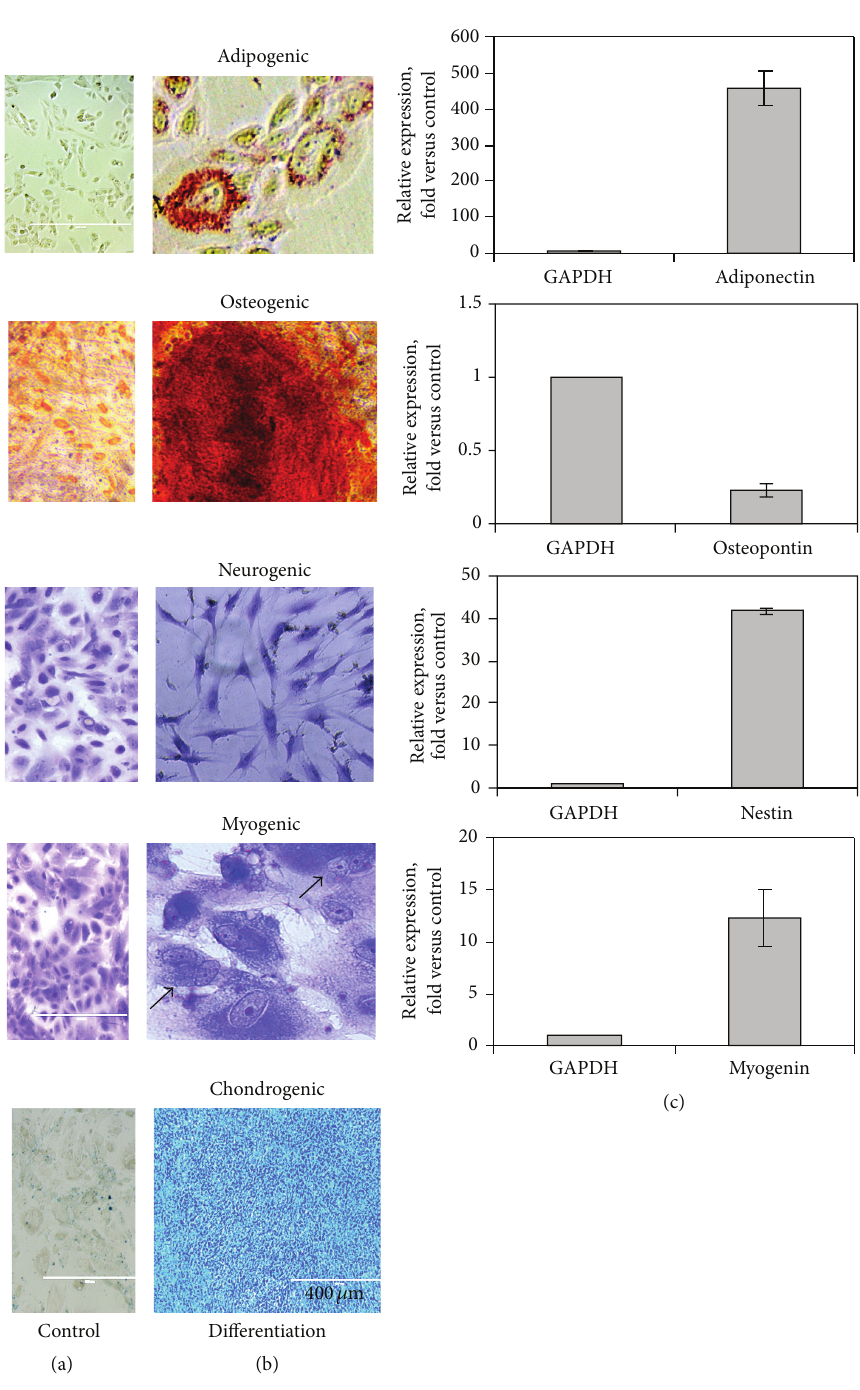
Figure 3: Differentiation potential of AF-MSCs. AF-MSCs were obtained from amniocentesis samples of second- and third-trimester at passages 5–8, cultured without differentiation supplements (a), or maintained in differentiation media. (b) Representative images of AF- MSCs after adipogenic treatment showing the accumulation of lipid vacuoles by Oil Red O staining; osteogenic treatment by Alizarin Red staining for calcium mineralization; neurogenic or myogenic treatment showing the presence of neuron-like cells or multinucleated cells by staining with crystal violet, respectively, and chondrogenic treatment showing glycosaminoglycan production in chondrogenic pellets by Alcian Blue staining. (c) Relative expression of adiponectin, myogenin, nestin, and osteopontin by RT-qPCR is presented as n -fold increase over untreated control. Data are presented as the mean ± S.N. ( 𝑝 < 0.05 ) for three independent